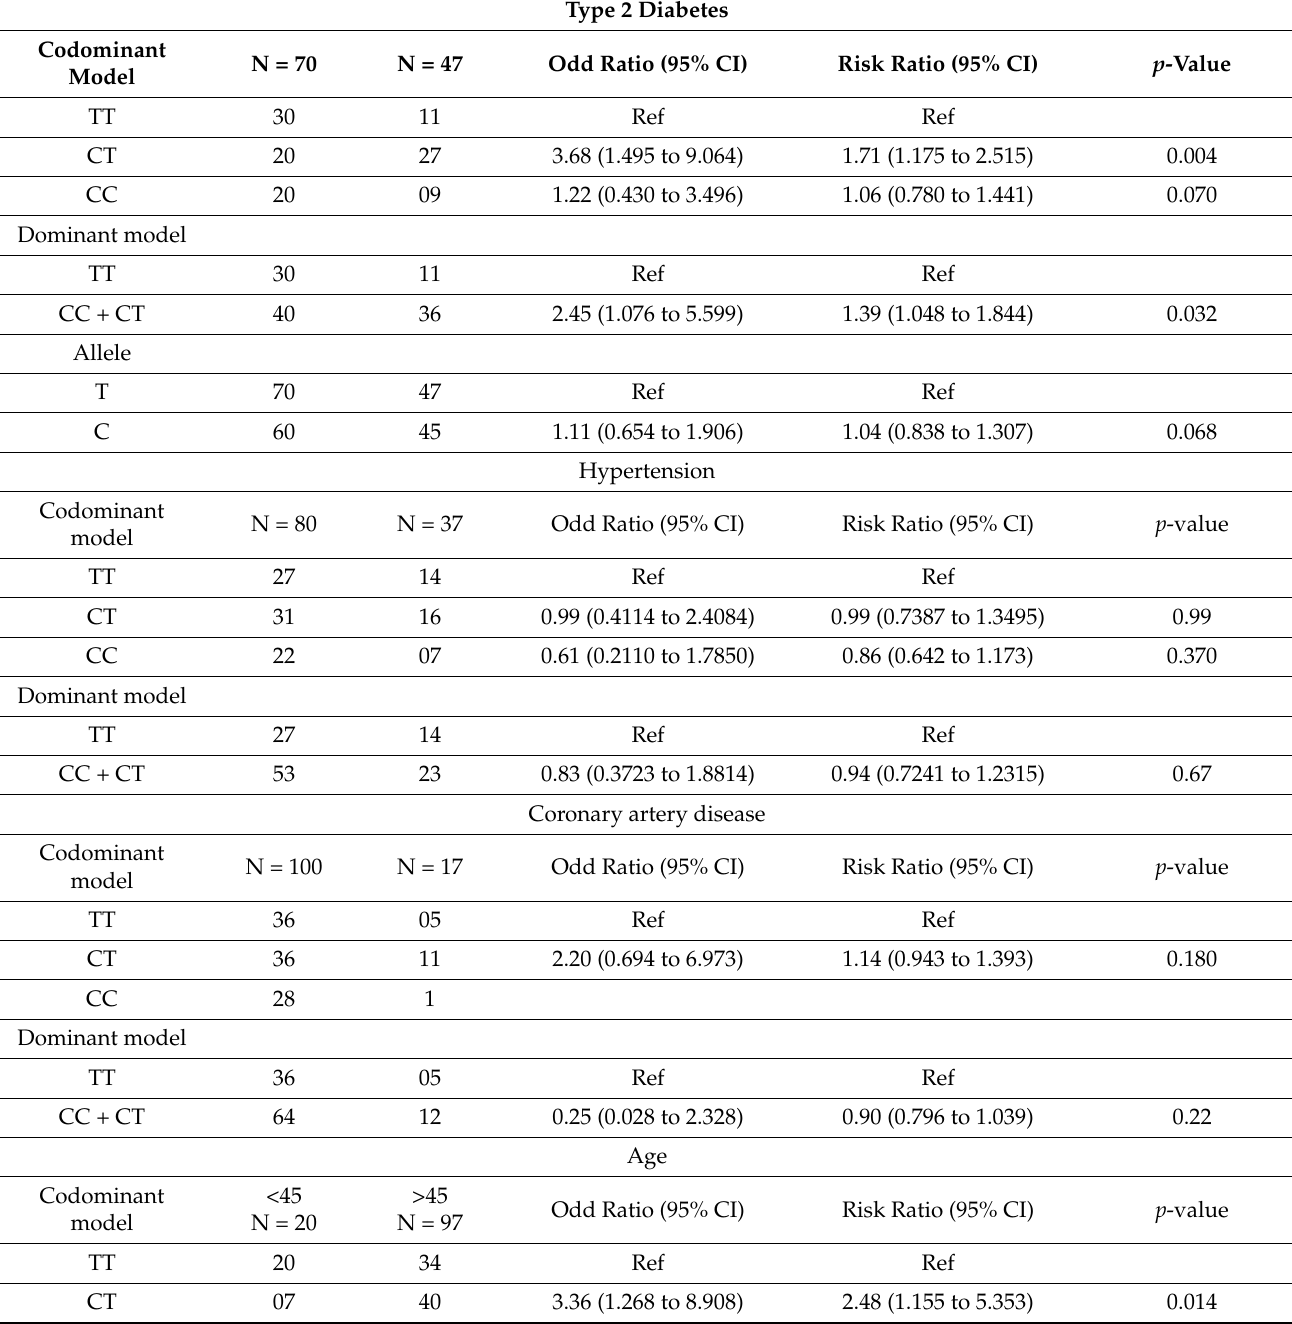
Table 12. Statistical comparisons ( p -values) of ACE2 rs4240157 T > C genotypes in COVID-19 patients with various